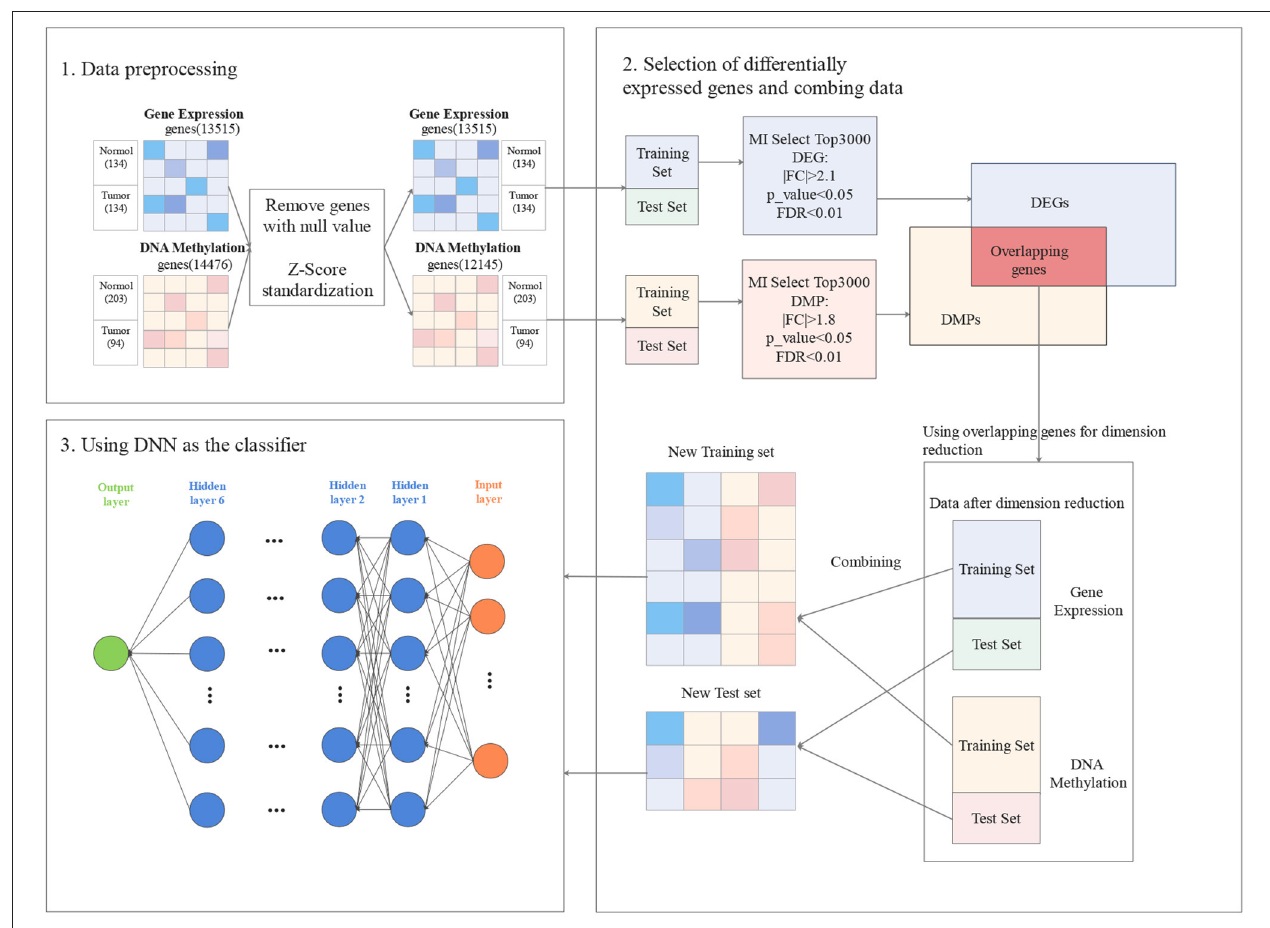
FIGURE 1 | The workflow of gastric cancer biomarker identification approach